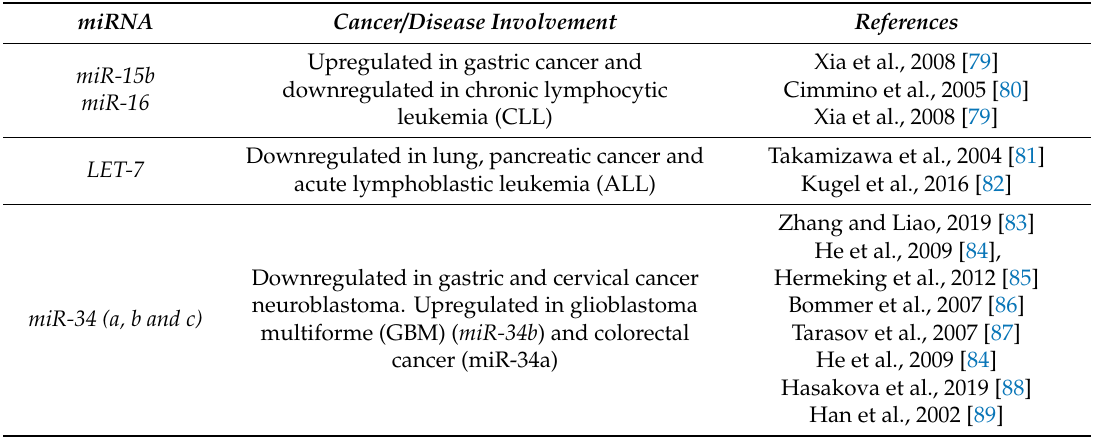
Table 3. MiRNAs implicated in multiple